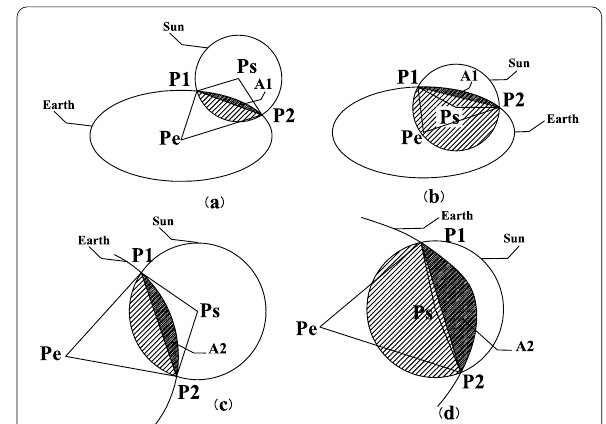
Fig. 3 Overlapping area of the Sun occulted by the Earth. a Shows the case where the circle and ellipse intersect, and the center of the solar disk is outside the ellipse; b shows the case where the circle intersects the ellipse, but the center of the circle is inside ellipse; c shows the case where the circle and hyperbola intersect, and the center of the circle is inside of the circle; d shows the case where the circle and the hyperbola intersect, but the center of the circle is inside of the overlapping region. In the figure, P1 and P2 are the intersection points between the circle and the conical curve, Pe and Ps is the projection point of the Earth’s center and the Sun’s center, A 1 and A 2 are the area formed by the intersection points and the conical